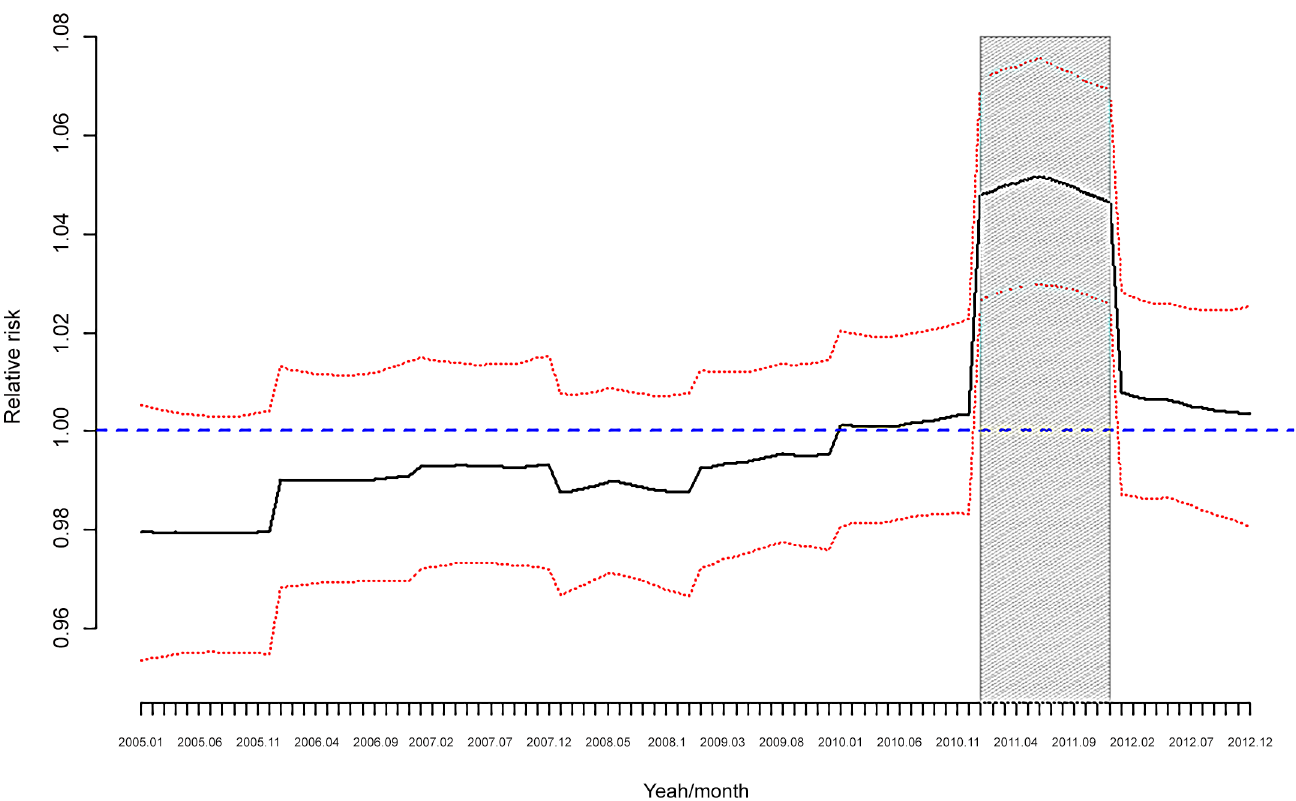
Fig 5. Number of drugs per person/month. Monthly data for the period 2005 – 2012. Shaded Statistically significant (the 95% credibility interval does not contain the unit).